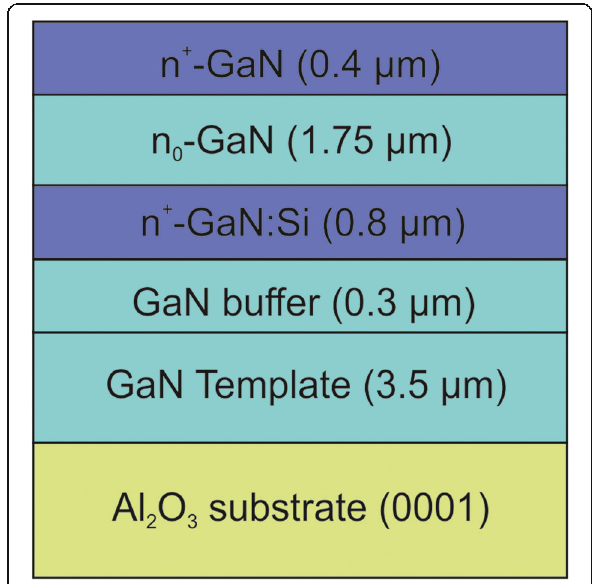
Fig. 1 Schematic of the investigated n + /n 0 /n + -GaN structure grown on GaN-template/(0001) sapphire